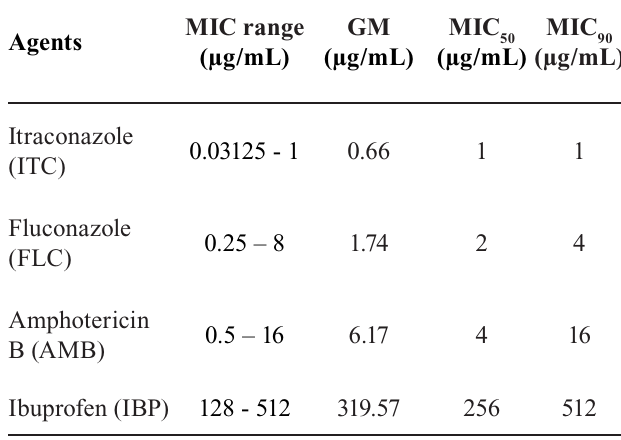
TABLE I - S usceptibility profile of twenty five isolates of Cryptococcus neoformans to antifungal agents. Rresults were expressed in ranges of variation of minimum inhibitory concentrations values (MIC ranges), geometric mean (GM) of 25 isolates, MIC50 (MIC value that inhibits 50% of the isolates) and MIC90 (MIC value that inhibits 90% of the